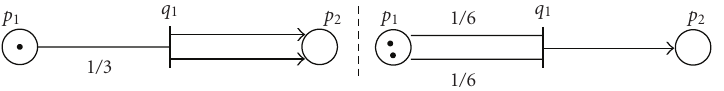
Figure 3: (Left): routing policy case 1. (Right): routing policy case 2.